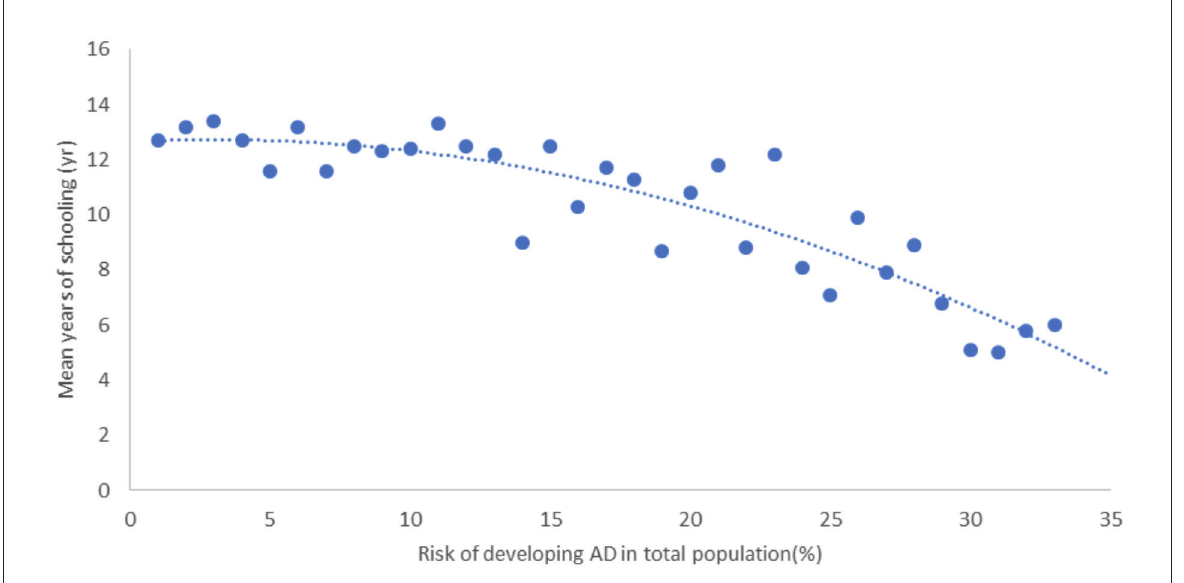
Figure 9. Correlation between level of schooling and risk of developing AD in total population